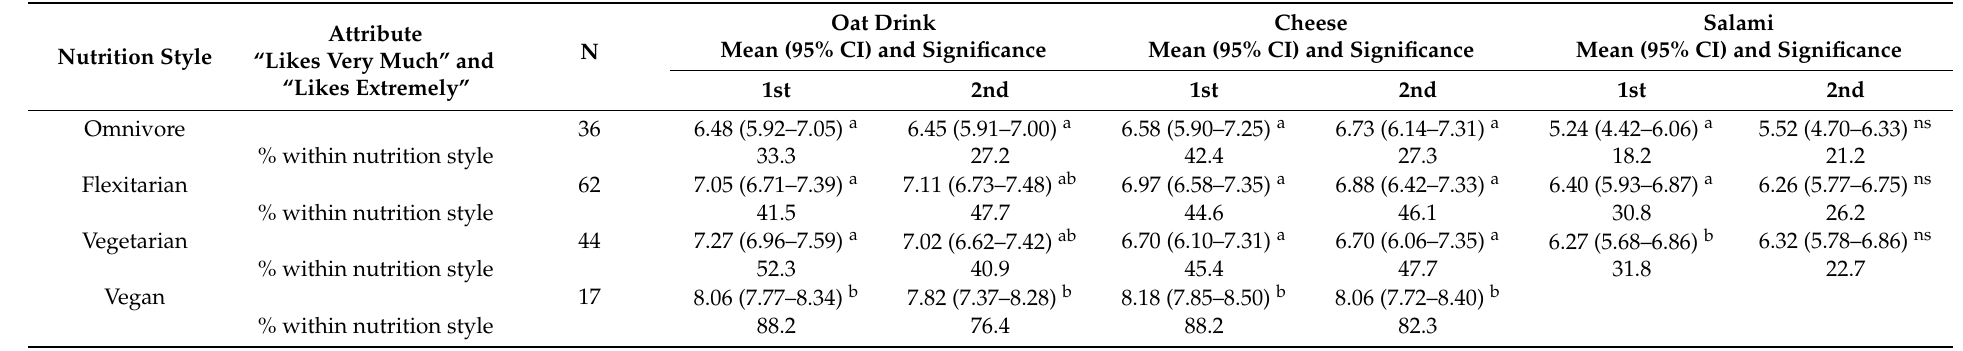
Table 5. Attribute overall liking for the plant-based alternative products in two sessions. Mean values of the 9-point hedonic scale with 95% confidence intervals and significance